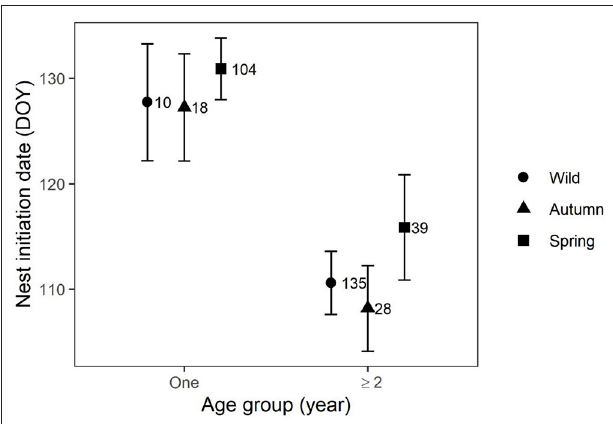
FIGURE 3 | Predictions of mean nest initiation dates ( ± CI), for wild-born and captive-bred migrant Asian houbara ( Chlamydotis macqueenii ) released in spring and autumn from two age